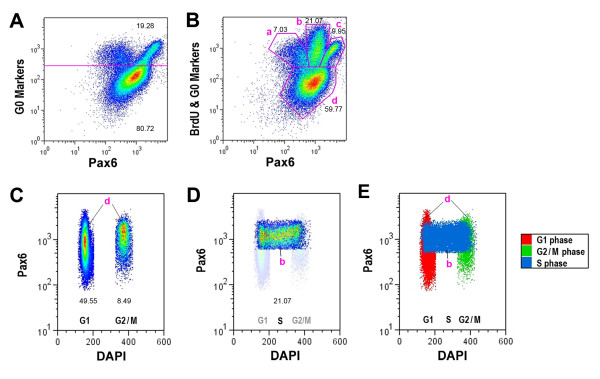
Correlation of Pax6 levels in progenitors in different phases of the cell cycle. Flow cytometric analyses of Pax6 levels among postmitotic cells and cycling progenitor cells at E7 (HH stage 32). (A) Cell density profile of total retinal cells labeled with Pax6 and a combination of neuronal markers, including Brn3a, Islet1/2, AP2a, and Visinin. Neuronal marker-positive cells (above the purple line) represent G0 cells; and neuronal marker-negative cells (below the purple line) are mostly progenitor cells. (B) Cell density profile of total retinal cells labeled with a combination of neuronal markers (same as in (A)), BrdU, and Pax6. Gated areas 'a' and 'c' represent postmitotic G0 phase cells; gated area 'b' represents BrdU+ S phase cells; gated area 'd' consists of G1, G2, and M phase cells. (C, D) Cell density profiles of G1 and G2/M phase cells (C) (as gated in area 'd') and S phase cells (D) (as gated in area 'b' in (B)) according to Pax6 levels and DNA content. In (D), G1 and G2/M cells are shown in the background as a reference to S phase cells. (E) Merged flow cytometry profiles of G1 (red), G2/M (green), and S (blue) phase progenitor cells according to Pax6 levels and DNA content. Flow cytometry profiles shown in (A, B) were generated with >85,000 cells. Numbers within each panel indicate percentage of gated cells among total cells.